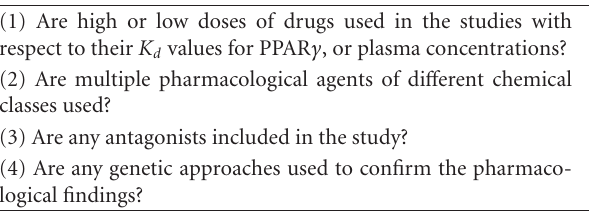
Table 3: Points to be considered to discern drugs/TZDs versus receptor e ff